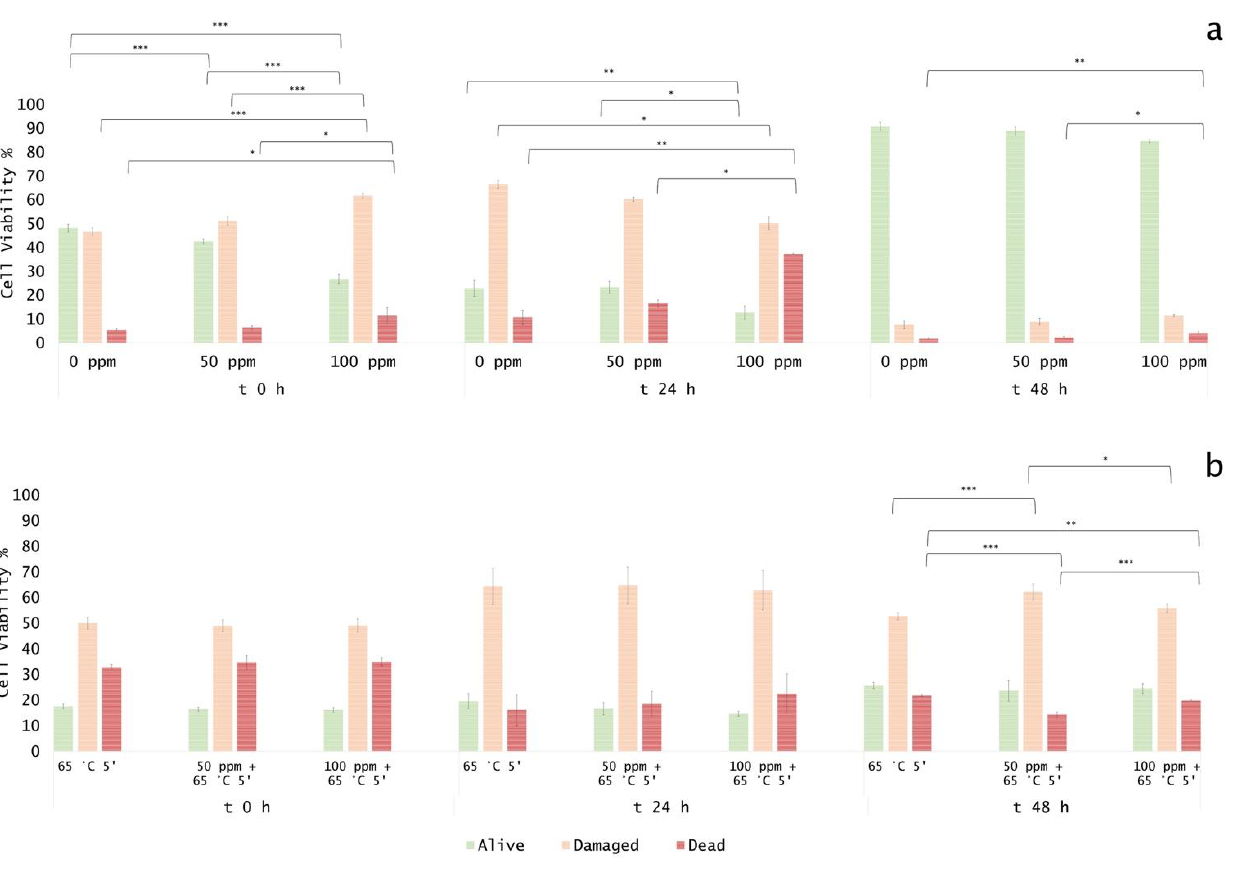
Figure 12. Percentage of alive, dead, and damaged cells calculated on total FCM events (100%) in fruit juice (pH 7). ( a ) EO treatment and ( b ) combined treatment at 65 °C 5 min. The shown values correspond to the means and respective standard deviations of replicates, independently analyzed. p -value less than 0.05 is flagged with one star (*), less than 0.01 with 2 stars (**) and less than 0.001 with three stars (***).